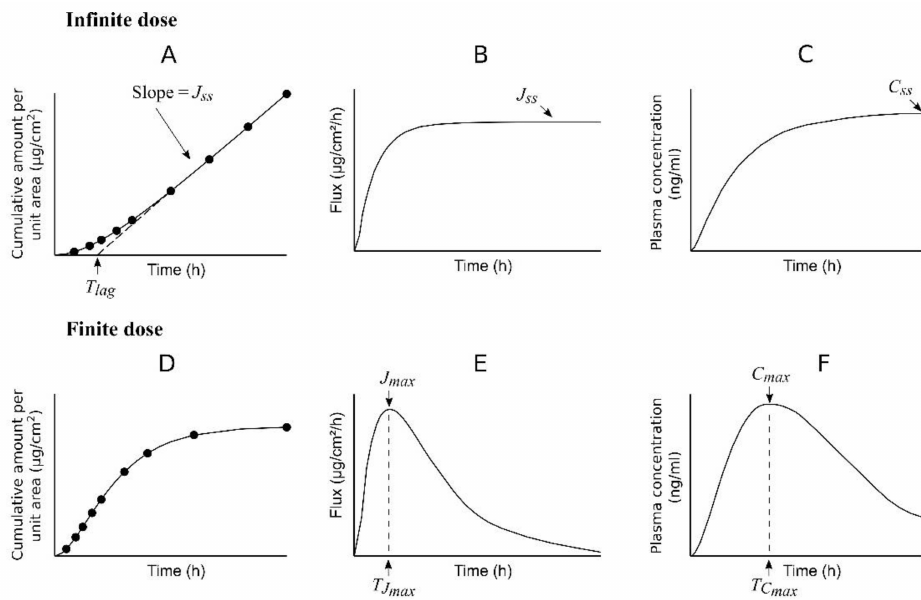
Figure 1. Graphs showing the different time profiles obtained with infinite ( A – C ) and finite ( D – F ) dose regimens. ( A , D ) cumulative amount of permeant in the receptor chamber, B and E: permeant flux, ( C , F ) plasma concentration of